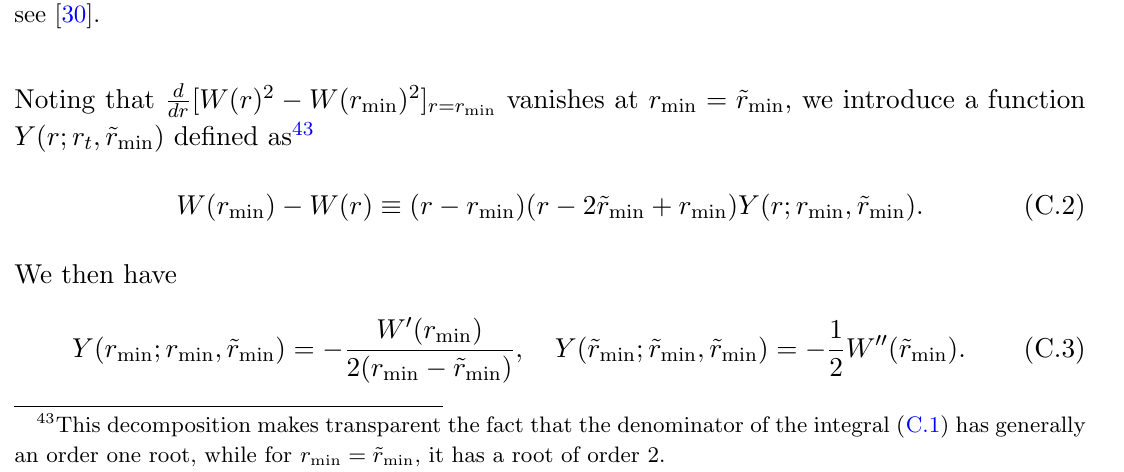
Figure 22 . Integrated complexity as a function of time for spherical (left) and planar (right) geometries in d = 3 boundary dimensions for various values of the horizon radius | r h = L (solid blue), r h = 1 : 5 L (dashed red), r h = 3 : 5 L (dot-dashed green). We see that it does not diverge at (cid:28) = (cid:28) c ( (cid:14)(cid:28) = 0). The value at (cid:14)(cid:28) = 0 has been set according to the complexity of formation, see